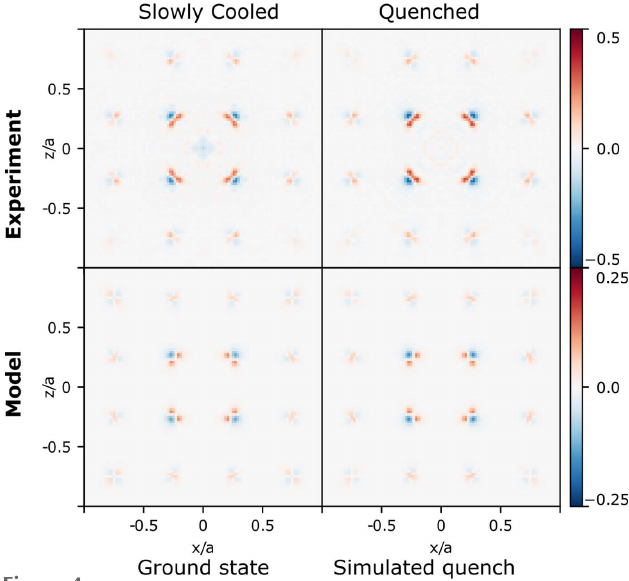
Figure 4 Measured and calculated 3D- (cid:3) PDF in the y = 0.27 a plane. This plane shows vectors which are all related to correlations between Co and other atoms. The top row shows the measured 3D- (cid:3) PDF for the two representative samples, and the bottom row shows the corresponding 3D- (cid:3) PDF calculated from the vacancy repulsion model with structural relaxations. Note that the experiment and model 3D- (cid:3) PDFare shown on different scales. The measured 3D- (cid:3) PDF has stronger amplitudes, indicating the model to still have something